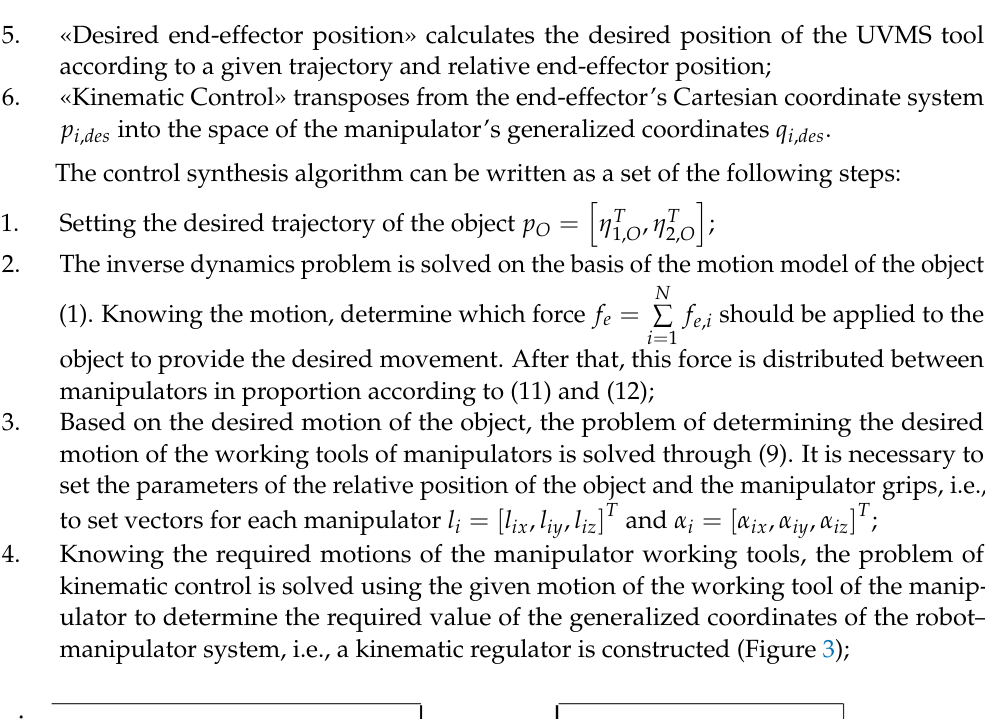
Figure 2. UVMS’s tracking control diagram.